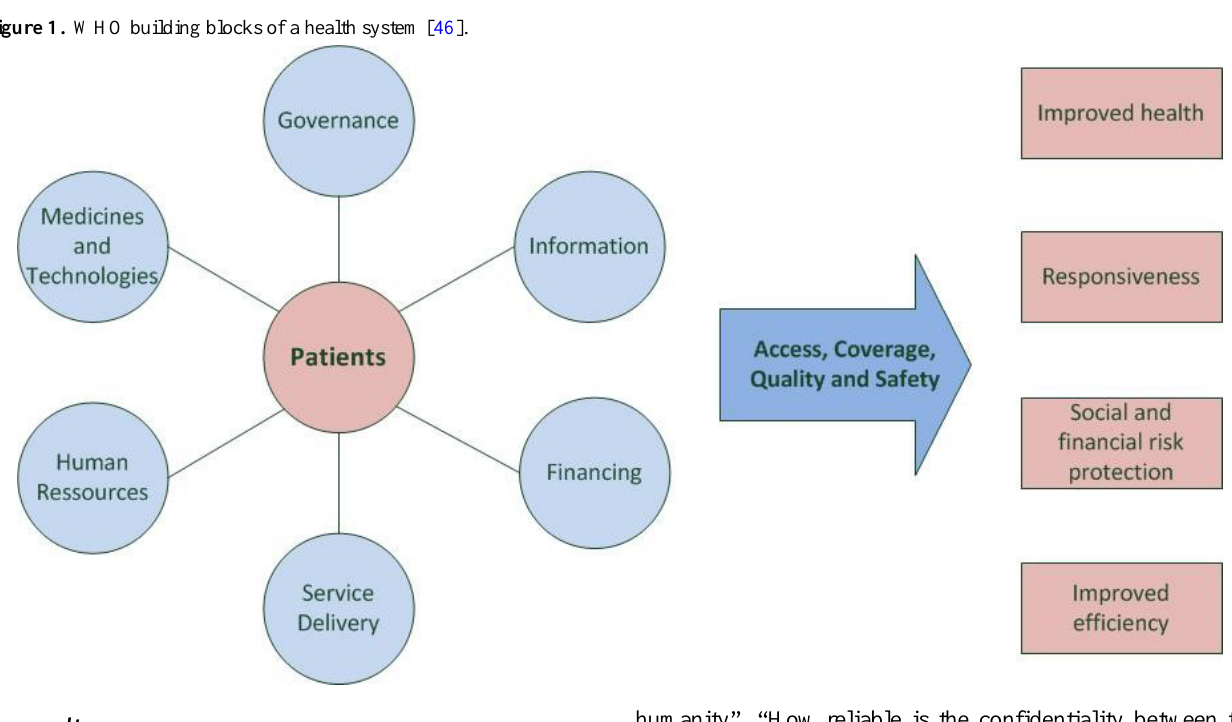
Figure 1. WHO building blocks of a health system